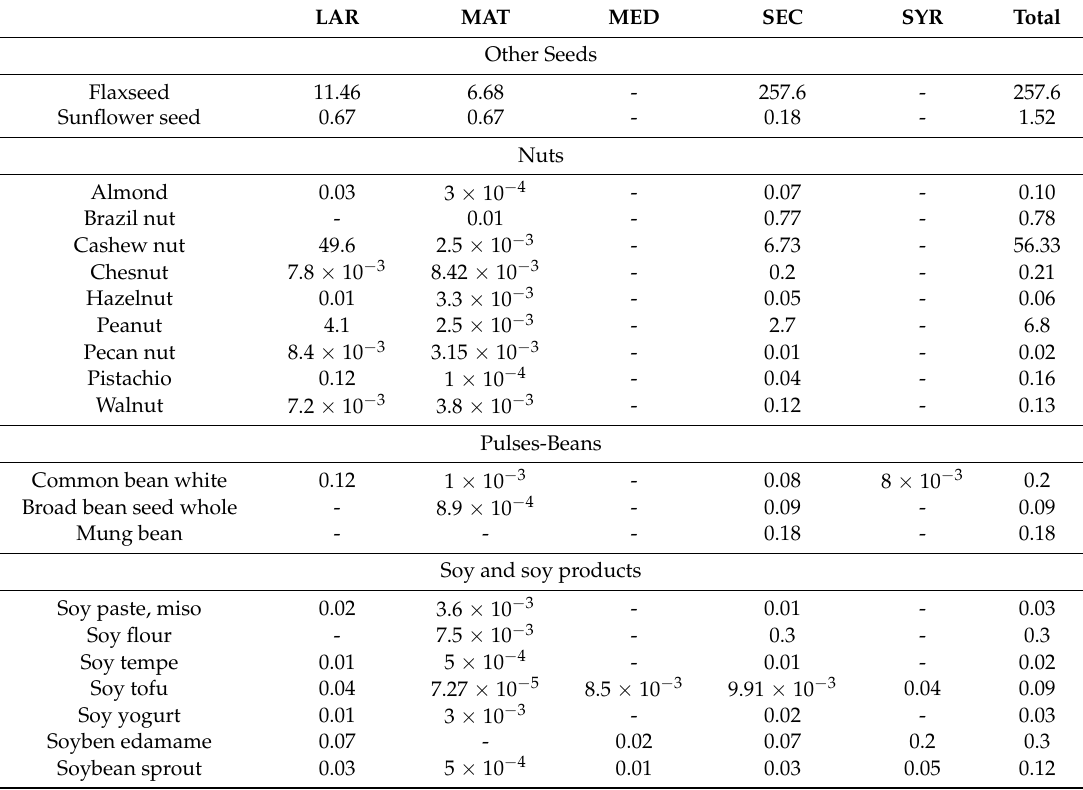
Table 2. Lignan content of seeds (mg/100g food)